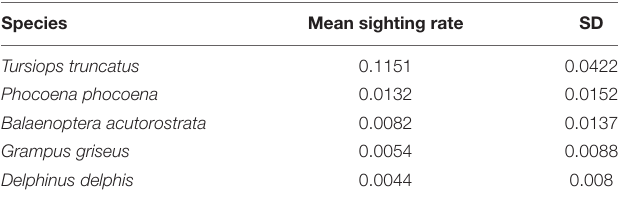
TABLE 6 | Mean sighting rate and standard deviation for each of the studied species.